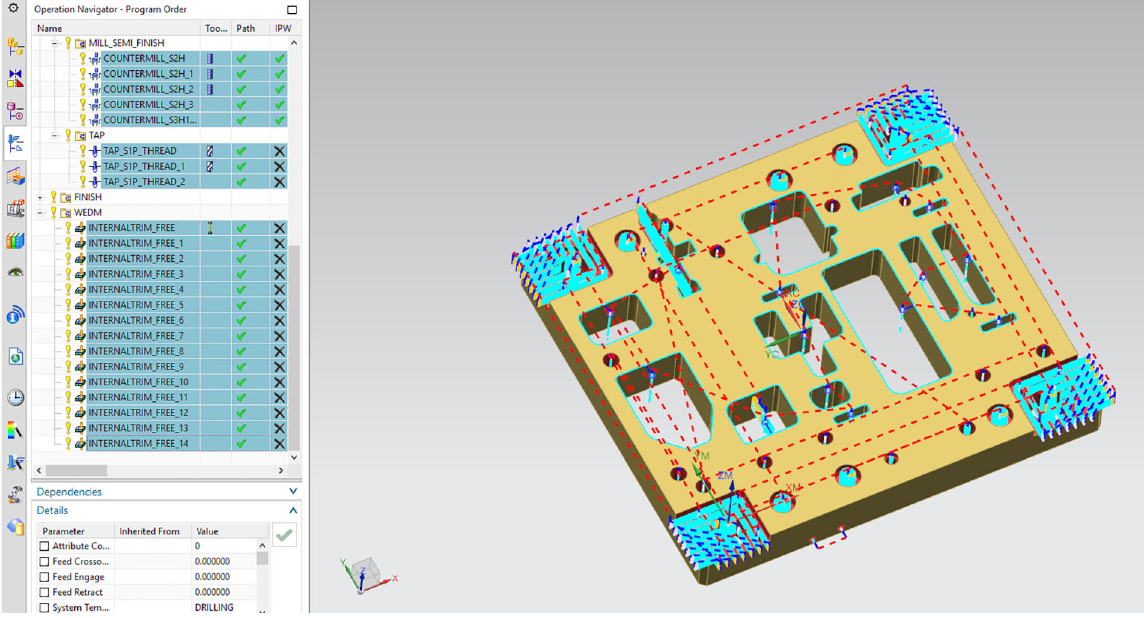
Fig. 9. Example work paths generated by the